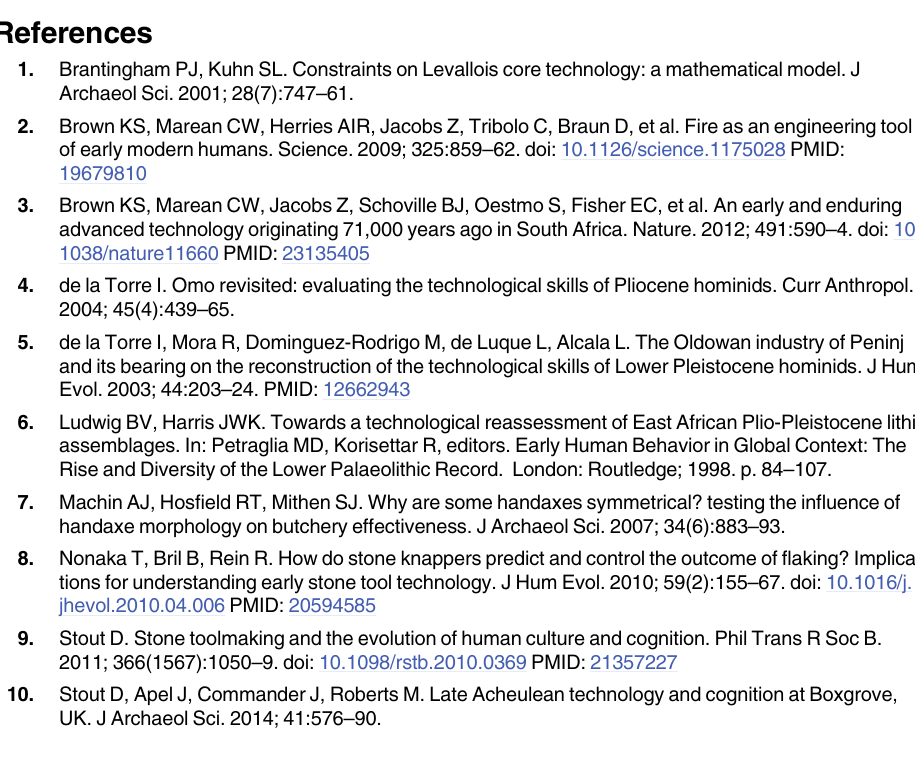
S1 Text. Pilot study testing the efficacy of using a standardised copper billet as an analogue for a range of natural soft